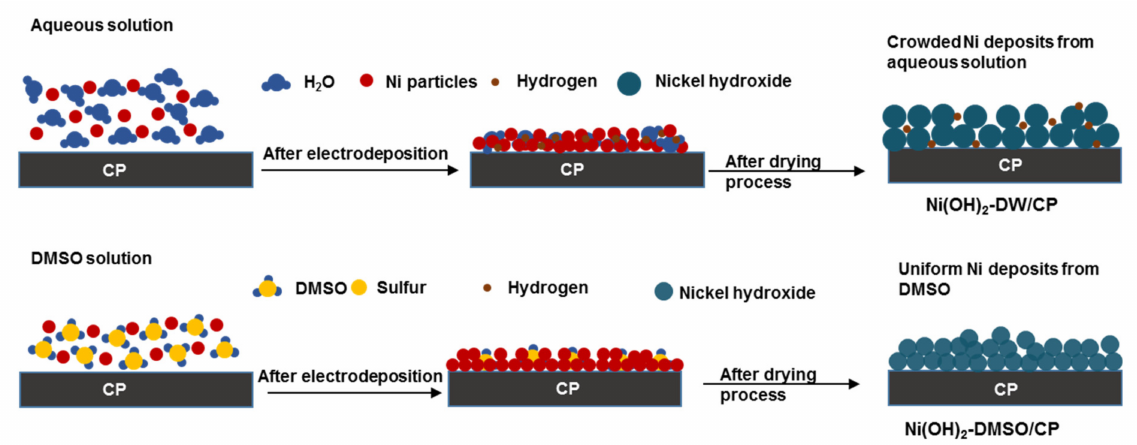
Figure 1. Schematic representation for the preparation of Nickel hydroxide electrodeposited on carbon paper under a aqueous and DMSO